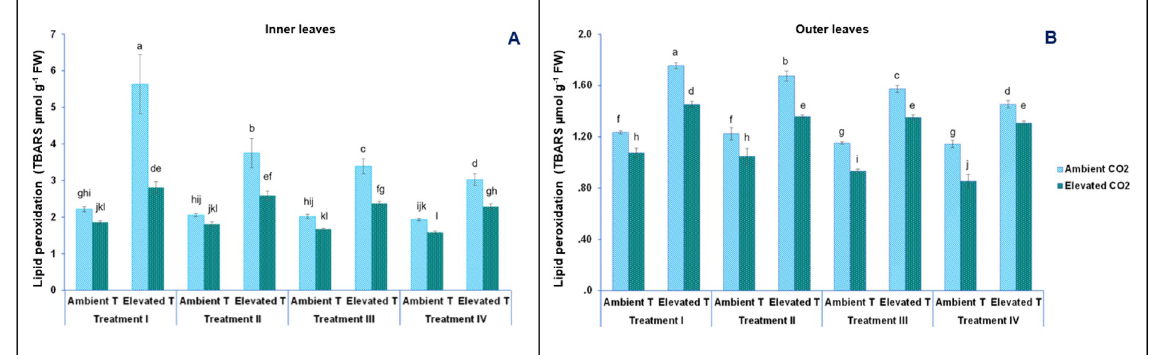
Fig 3. Effect of the short-term heat stress on lipid peroxidation (TBARS μ mol g -1 FW) in inner (A) and outer (B) leaves of baby-leaf lettuce cv Derbi at two levels of CO 2 and four different NO 3- /NH 4+ treatments. Different letters are significantly different according to Tukey’s test at p � 0.05.